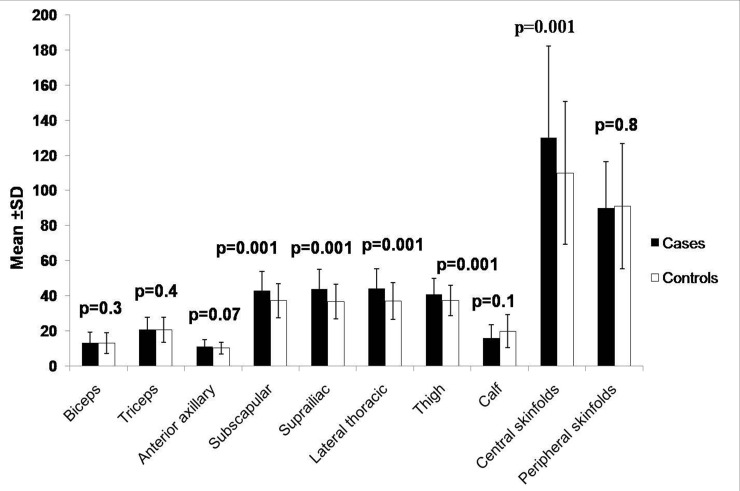
Comparison of skinfold thickness between cases (n = 162) and controls (n = 173).Central (sum of subscapular and suprailiac) and peripheral skinfold thicknesses (sum of biceps and triceps) were calculated.